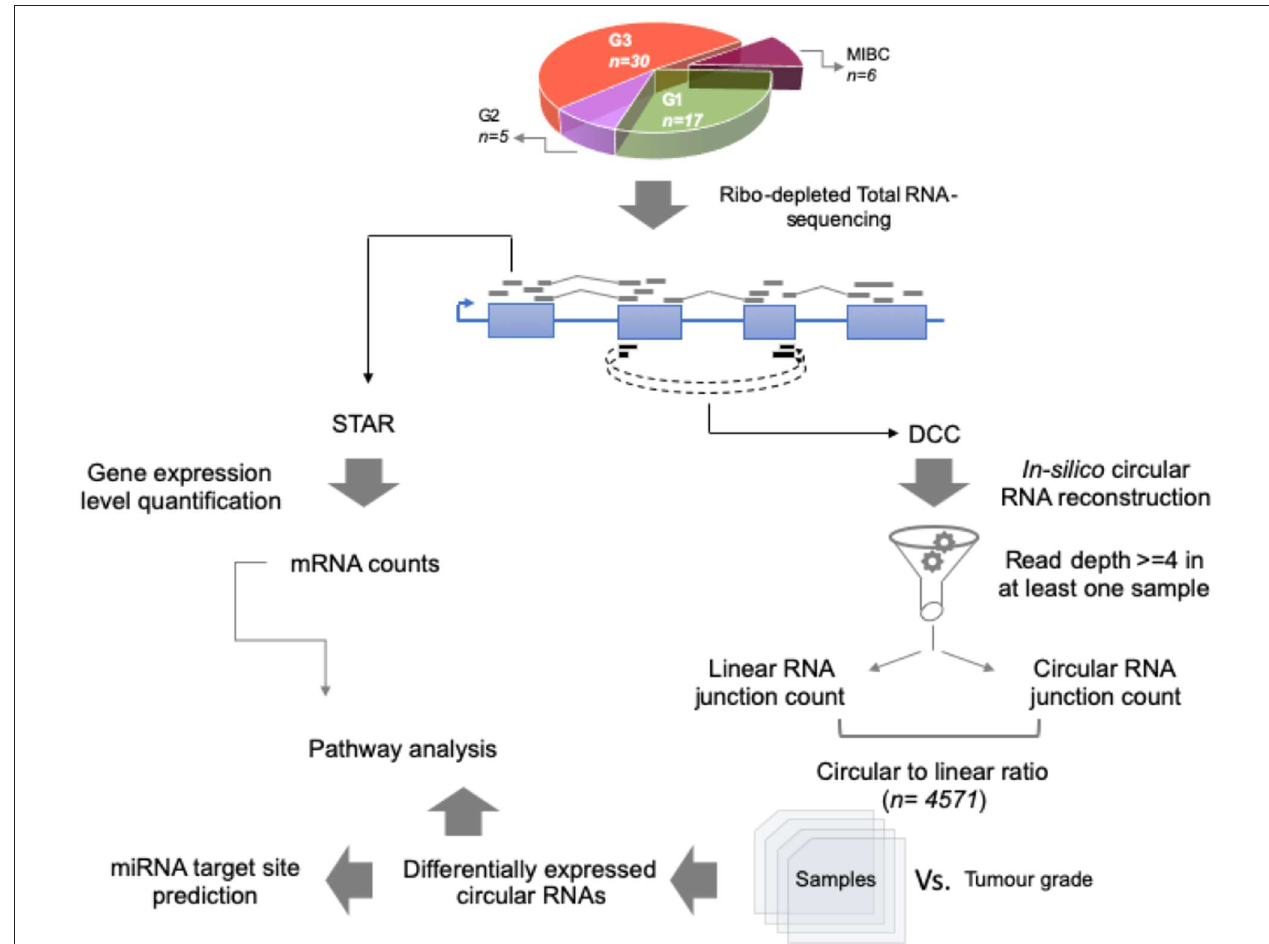
FIGURE 1 | Work flow for identification of circular RNA candidates in context of non-muscle-invasive bladder cancer subtypes. Using 58 patient tumor tissue samples across G1, G2, and G3 tumor grades for NMIBC and additionally 6 MIBC samples, total RNA-sequencing was performed using Illumina platform. Coordinate boundaries for circular RNA candidates were in-silico reconstructed using DCC algorithm. For each circular RNA candidate, simultaneous evidence for back-spicing and linear splicing (circular RNA count and linear RNA count, respectively) were quantified which were then used to calculate the circular-to-linear ratio for each candidate. These ratios were then subjected to differential expression statistics using the limma BioConductor package. The differentially expressed circular RNAs across the tumor grade subtypes were then used for pathway analysis based on the host gene name. Further the circular RNA sequence body was checked for harboring potential miRNA target sites using TargetScan